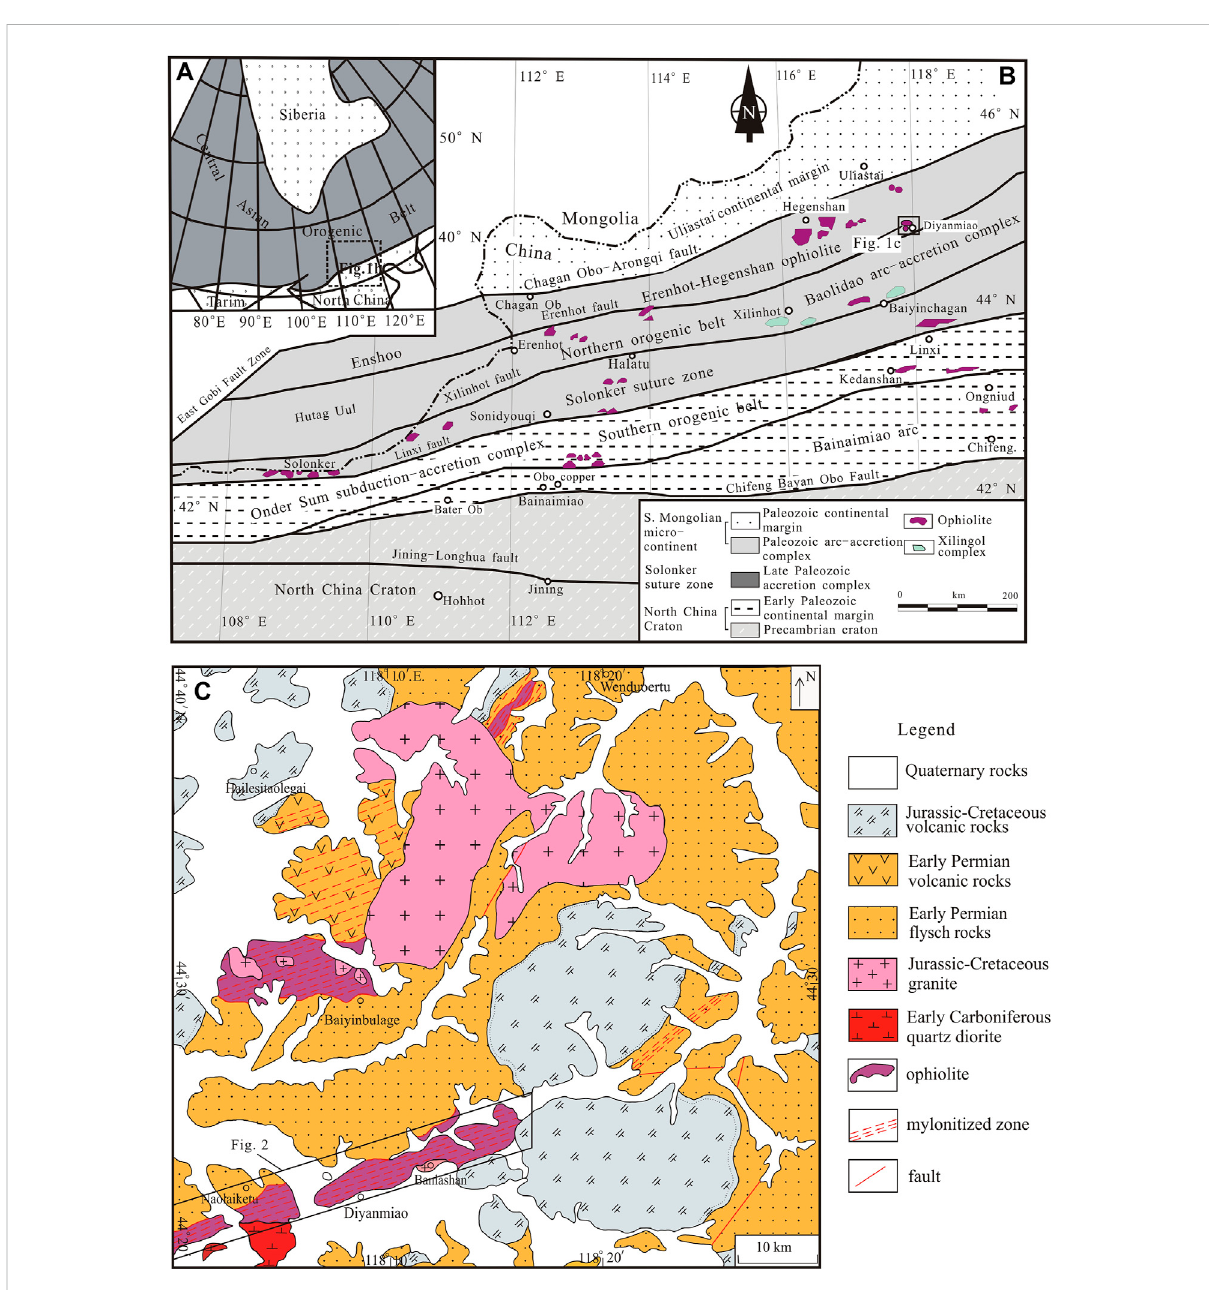
FIGURE 1 (A) Schematic tectonic division of north China-Mongolia segment (modi fi ed from Jahn, 2004). (B) Sketch geological map of the late Paleozoic crust of southeastern Inner Mongolia (modi fi ed from Xiao et al., 2003). (C) Simpli fi ed geological map of the Diyanmiao area (modi fi ed after Li et al.,